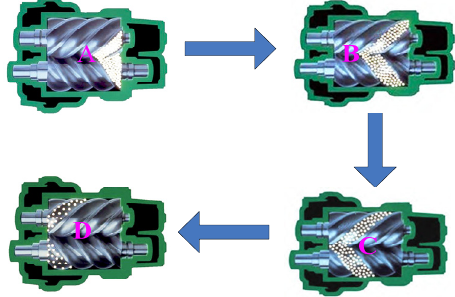
Figure 4. The schematic diagram of operating principle of screw expander.